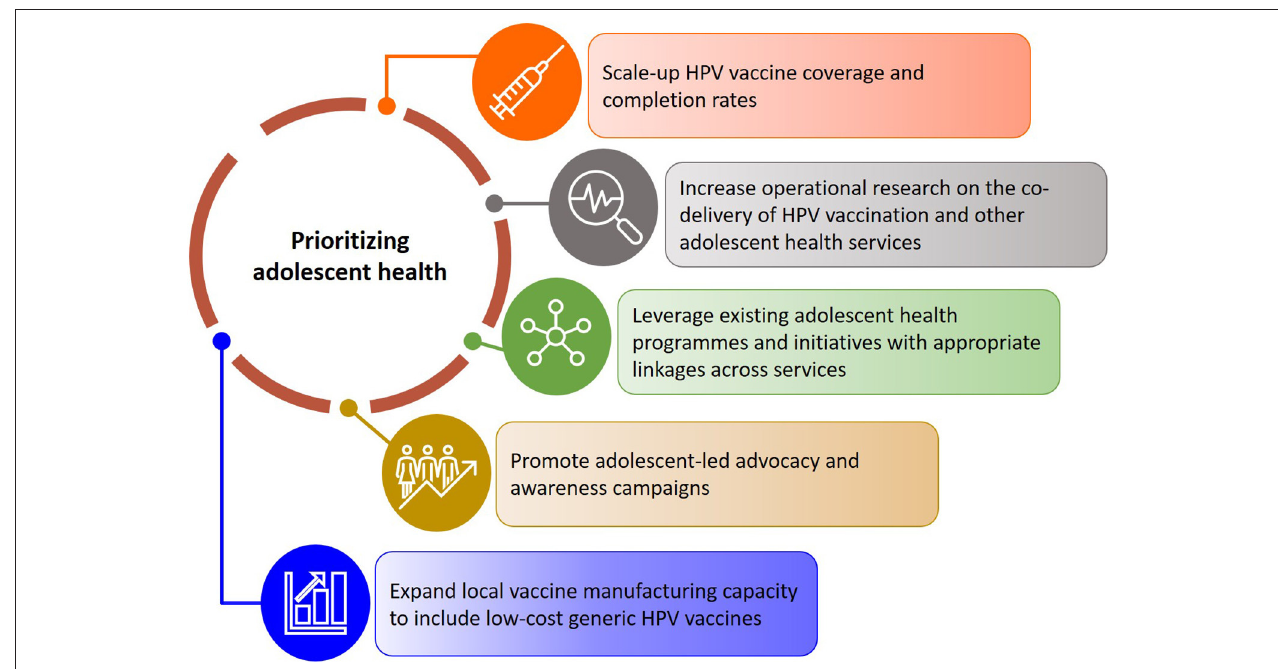
FIGURE 3 | Recommendations for scaling up adolescent health services alongside the HPV vaccination programme in South